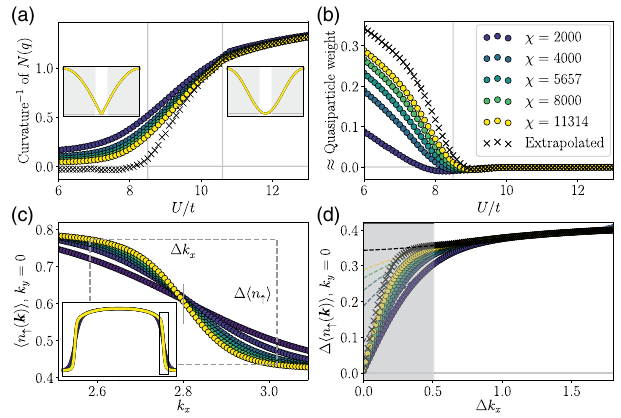
FIG. 4. Measurements pertaining to the metal-insulator tran- sition for the YC4 cylinder. (a) Inverse curvature of the density- density structure factor at k ¼ 0 , a proxy for the charge gap, with vertical lines at U=t ¼ 8 . 5 and 10.6 indicating the estimated locations of phase transitions. The insets show that the structure factor is linear around k ¼ 0 for small U=t and quadratic at large U=t , indicating gapless and gapped phases, respectively; curva- ture is measured using a small interval around k ¼ 0 , the nonshaded region in the insets. (b) Approximate fermionic quasiparticle weight, measured by discontinuity in occupation at the Fermi surface. The vertical line is at U=t ¼ 8 . 5 . As described in the text, this is an indirect calculation rather than a direct measurement; the calculation is illustrated in the next two panels for one value of U=t , with further examples available in the Supplemental Material [56]. (c) Occupation of spin-up electrons as a function of k x , with k y ¼ 0 , for U=t ¼ 6 , both for the full Brillouin zone (inset) and for the edge of the Fermi surface, identified as the point with the steepest slope. The gap in occupation Δ h n i can be measured as a function of the size Δ k x of an interval symmetric around the Fermi surface. The result is shown in the next panel. (d) Change in occupation Δ h n i across an interval Δ k x around the Fermi surface. Small Δ k results are not reliable because of Luttinger liquid effects from the one- dimensionality of the cylinder and because occupations are calculated by a finite range of real-space correlations. We therefore eliminate the points in the shaded region and fit the remainder with a cubic polynomial, then extrapolate to Δ k x ¼ 0 as shown by the dashed lines. These extrapolated results are the data shown in the structure factor is visibly linear near k ¼ 0 , shown in Fig. 4(a) (left inset), while at high U it is clearly quadratic (right inset). To observe the metal-insulator transition, we measure the curvature of the structure factor at k ¼ 0 and then extrapolate in the bond dimension. The extrapolated data reveal a transition from linear to quadratic at U=t ≈ 8 . 5 , consistent with the extrapolated chiral order parameter.